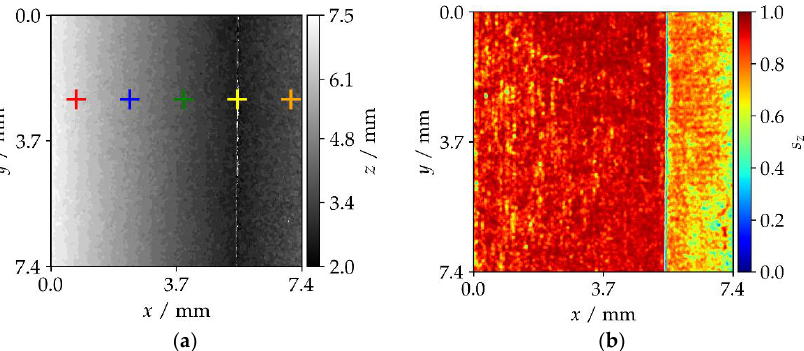
Figure 7. Shape-from-focus output including phase smoothness 𝑠 𝑧 as the quality criterion, high values show a strong result; ( a ) discrete focus map 𝑧 𝑜𝑝𝑡,𝑚𝑎𝑥 reconstructed by pixel wise shape-from- focus maximum. The 𝑧 sections at colored crosses are illustrated in Figure 6; ( b ) optimized values of 𝑠 𝑧 using maximum filter.